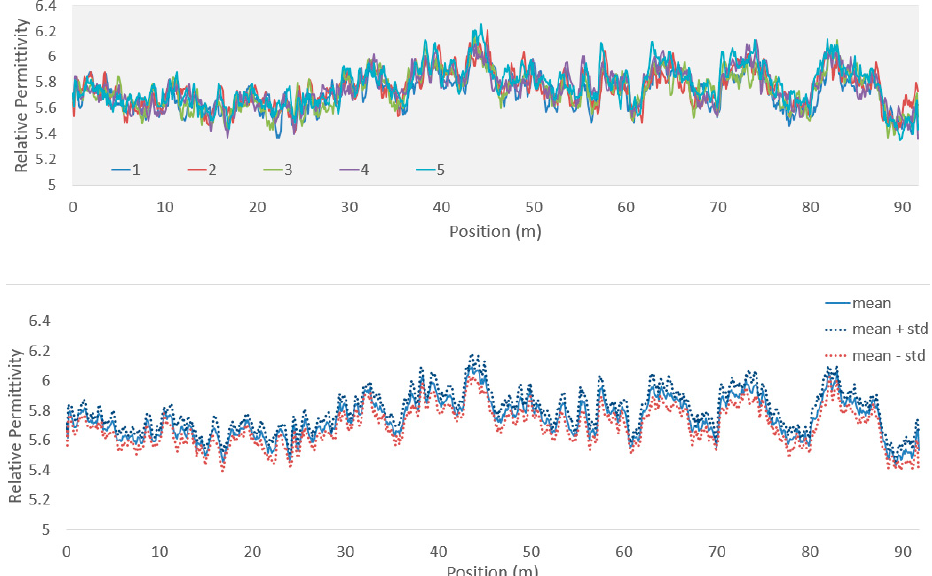
Figure 3. Plot of the k r values along a 90 m test line with five repeat passes shown to illustrate the PDP data repeatability (top), where numbers 1 to 5 indicate the number of repeats of the test. Plot of the mean k r value at each position along the line, plotted together with the ± standard deviation (bottom). Relative permittivity values range from about 5.40 to 6.20.